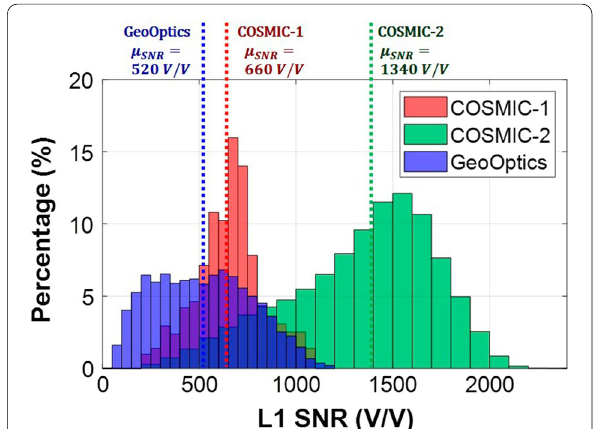
Fig. 7 Histograms of L1 SNR for COSMIC-1 (red bar), COSMIC-2 (green bar) and GeoOptics (blue bar). The mean values of SNR for each RO system are indicated with the dotted lines